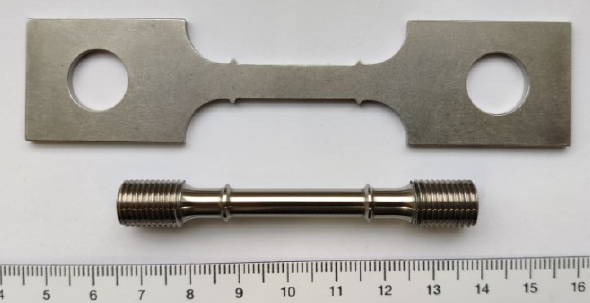
Figure 2. Flat and round geometries of the tensile specimens (marker unit in cm).